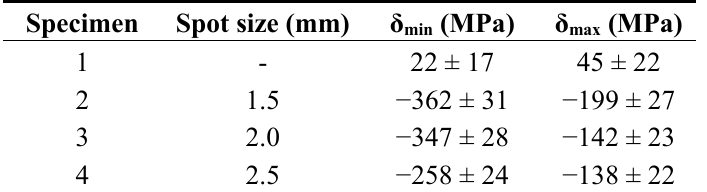
Table 3. Near surface residual stress data (depth of 33 µm)